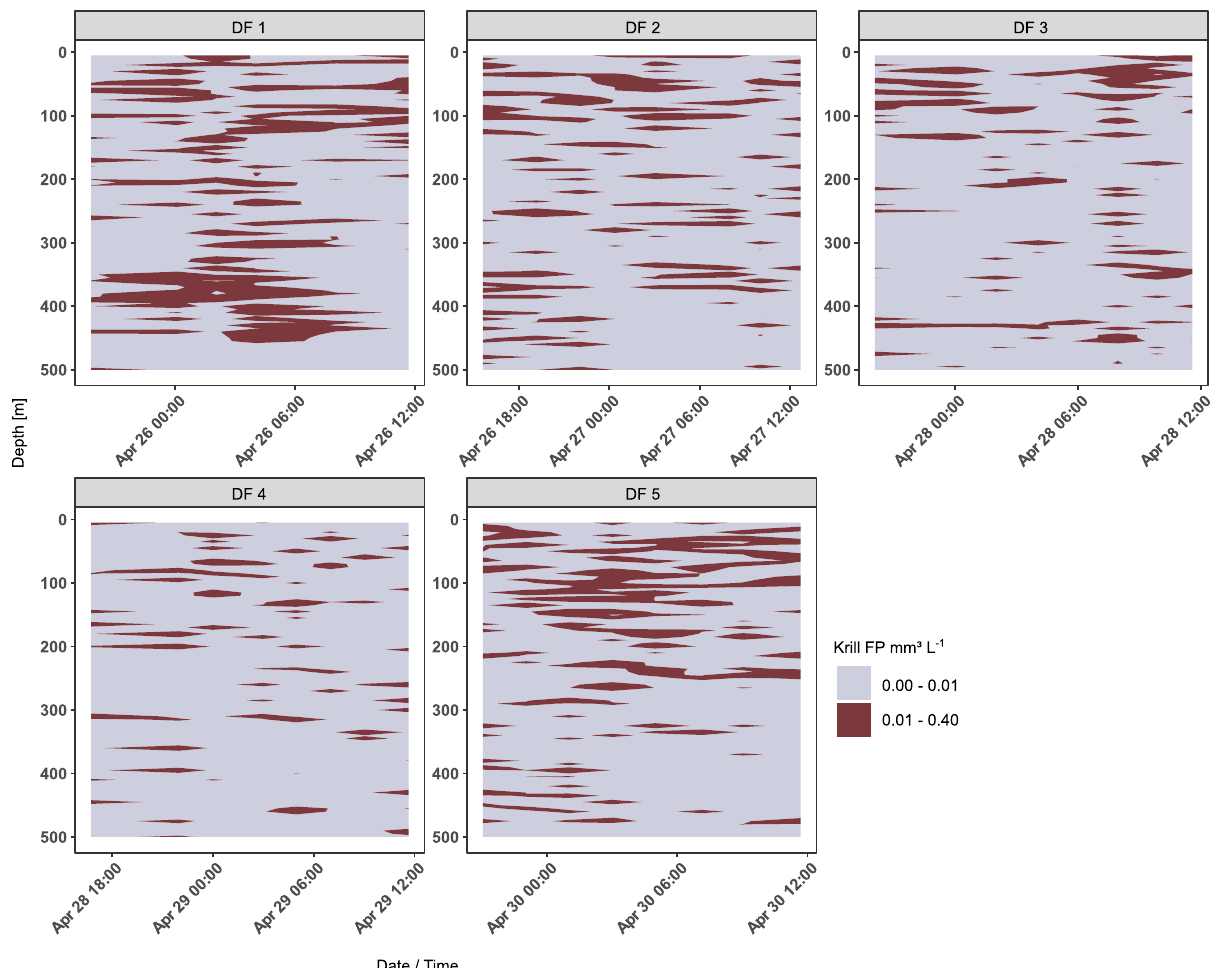
Fig. 3 Volume concentration of krill faecal pellets (FP). The volume concentration of krill FP is given in mm − 3 L − 1 as determined from the in-situ particle camera pro fi le for each of the fi ve drifting trap (DF) deployments, respectively. Clouds of krill FP sinking through the water column over time are shown on the x-axis for each DF deployment (DF 1 –